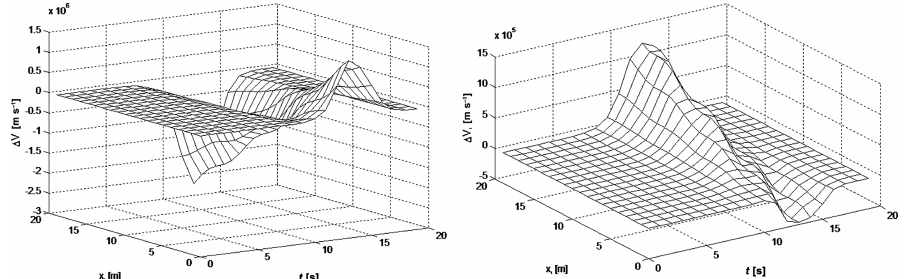
Figure 5. Propagation of initial sliding with different initial